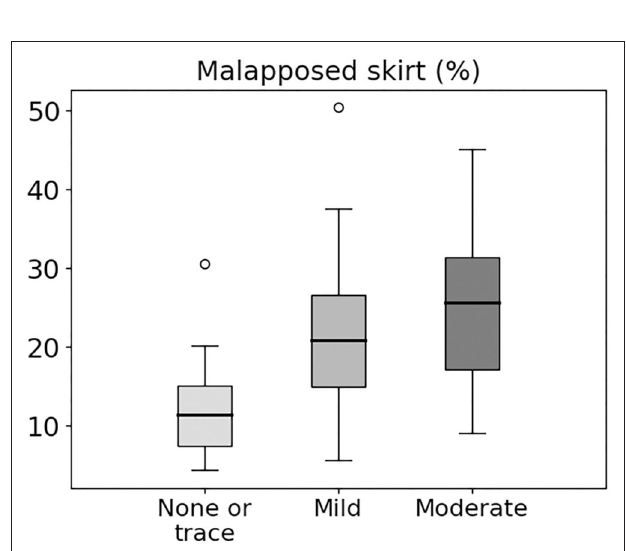
FIGURE 4 | Box and whiskers diagram showing predicted skirt malapposition for patients with none or trace, mild, and moderate PVL. Extreme values are presented as small circles